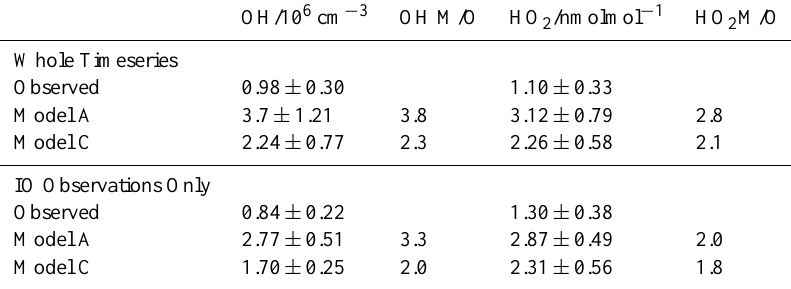
Table 3. Comparison of modelled and observed mean daily maximum OH and HO 2